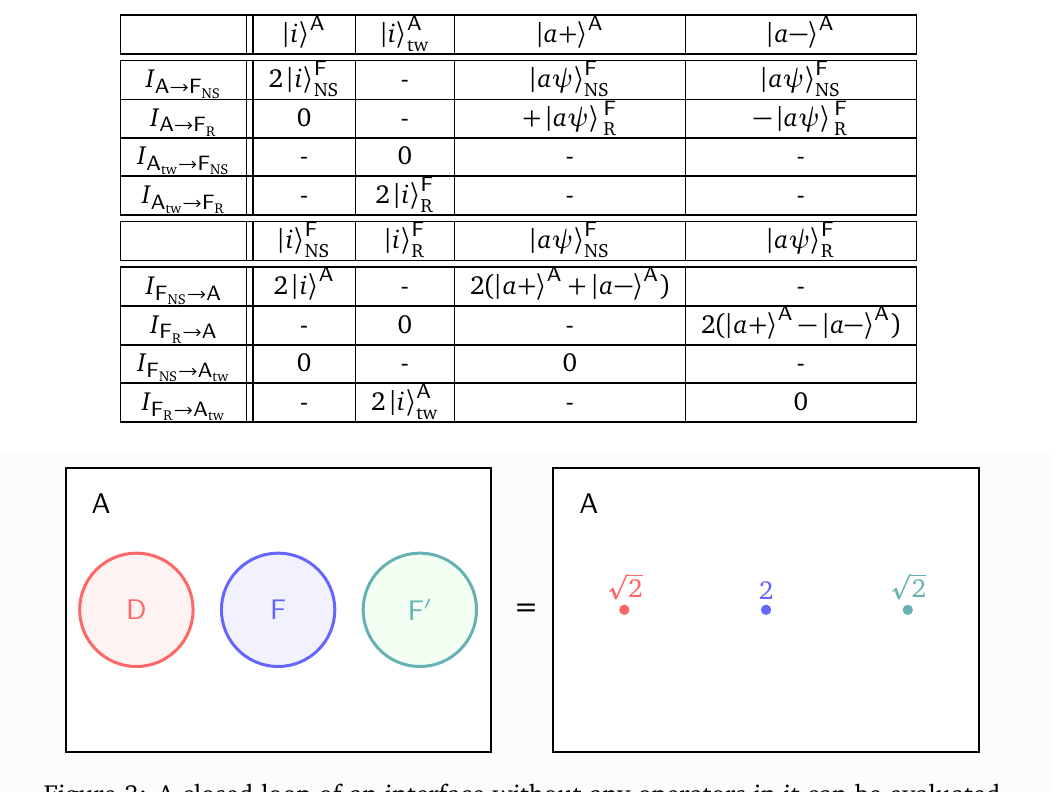
Figure 3: A closed loop of an interface without any operators in it can be evaluated to a number. This number can be called the quantum dimension of the interface, generalizing the same quantity for topological line operators of a single